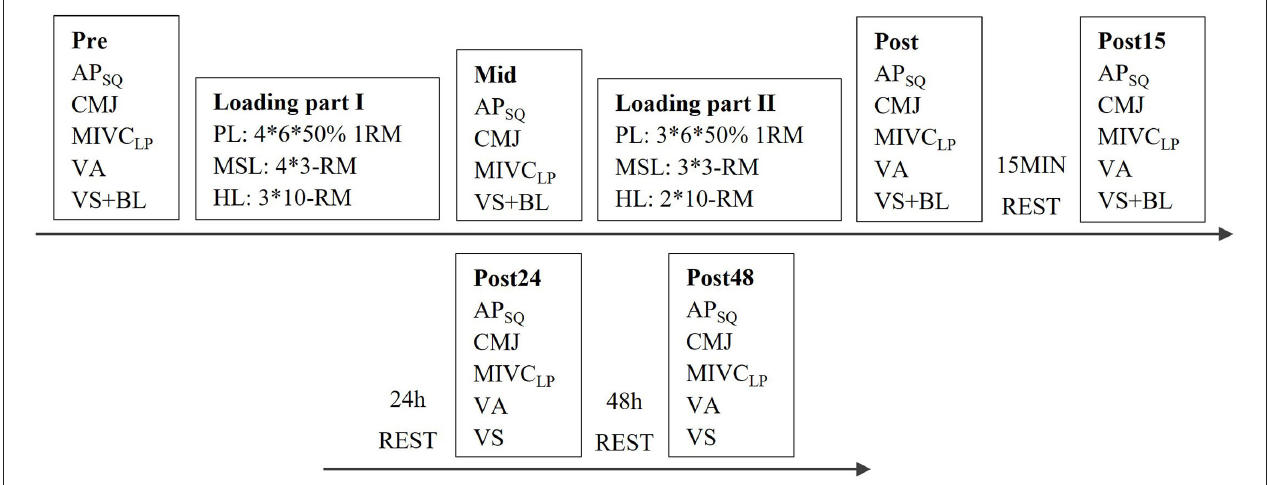
FIGURE 1 | Study design and the measurement procedures during the power (PL), maximal strength (MSL), and hypertrophic (HL) loadings. AP SQ , average power during back-squat in Smith machine; CMJ, countermovement jump height; MIVC LP , maximal bilateral isometric force in leg press; VA, voluntary activation of quadriceps femoris; VS, venous blood sample; BL, blood lactate